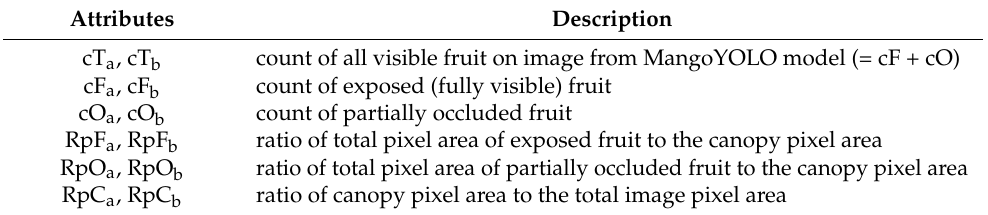
Table 4. Description of input variables used for MLP_yield and Random_forest_yield models. Subscripts a and b represent data for side A and side B images of a tree, respectively.